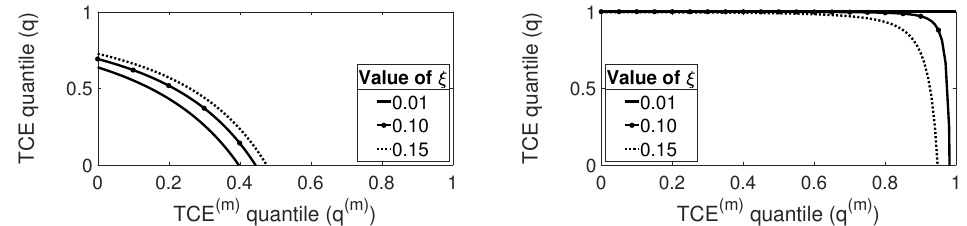
Figure 8. TCE quantile as a function of extended TCE quantile at order 2. ( Left panel ): θ = 1. ( Right panel ): θ =